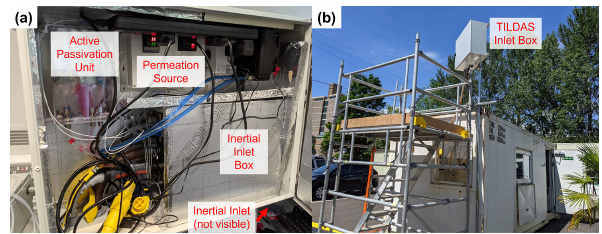
Figure 2. (a) Field configuration for HCl TILDAS inlet